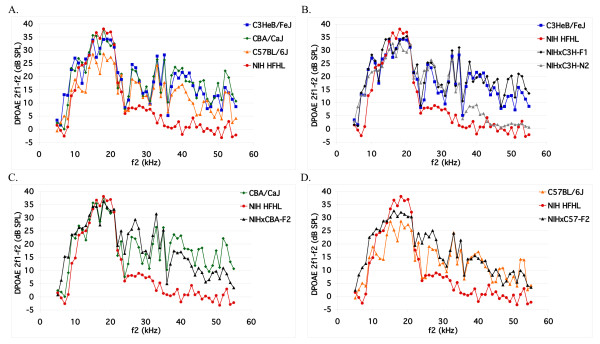
Distortion product otoacoustic emissions. Average DP-grams for mice (8–10 weeks old) in response to 5–55 kHz f2 inputs of 65 dB intensity. Distortion product amplitudes have been corrected to account for differences in noise floors between samples. (A) DP-grams of mice from each of the 4 parental strains: C3HeB/FeJ (n = 17), CBA/CaJ (n = 12), C57BL/6J (n = 12), NIH Swiss HFHL (n = 12). (B) DP-grams for the parental, F1 (n = 8), and N2 (n = 306) populations for the NIH Swiss HFHL x C3HeB/FeJ cross. (C-D) DP-grams for the parental and F2 populations for the (C) NIH Swiss HFHL x CBA/CaJ (n = 294) and (D) NIH Swiss HFHL x C57BL/6J crosses (n = 320). DPgrams of parental strains were redrawn in (B-D) for comparison.